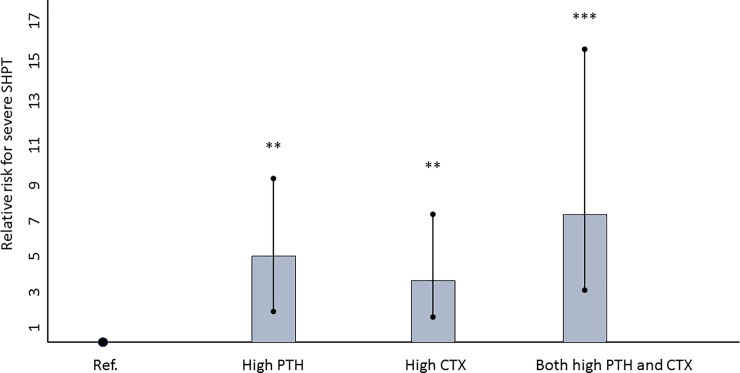
Relative risk of future severe SHPT according to the baseline CTX or / and PTH values.High CTX: > 1.2 μg/L; high PTH: > 374 pg/ml. ** p< 0.001; *** p< 0.0001.